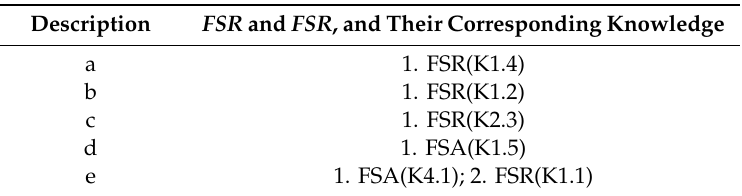
Table 2. FSRs and FSRs in FLD.